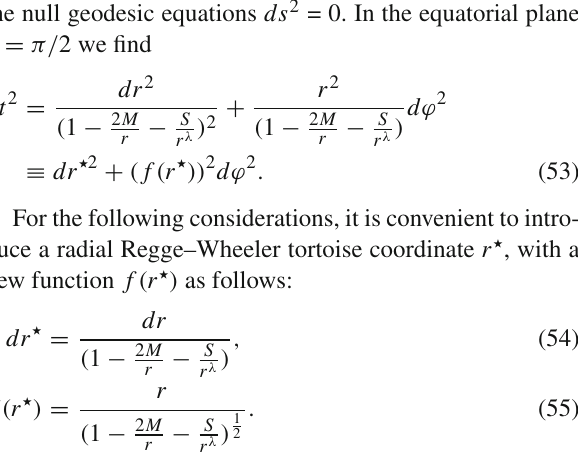
Fig. 1 We plot the deflection angle as a function of x = r 0 / 2 M . In the first plot we have chosen M = 1 and S = 0 . 8. One can observe that with the increase of λ the deflection angle decreases for fixed valued of M and the scalar charge being positive i.e. S > 0